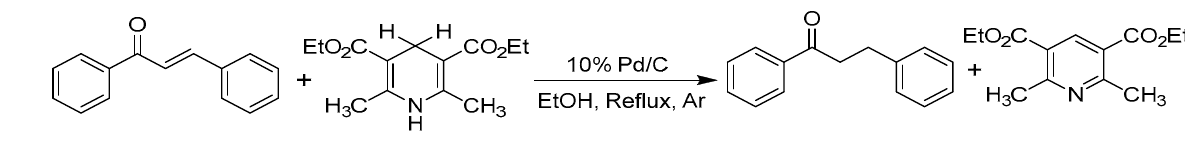
Scheme 3. Synthesis of saturated ketones.